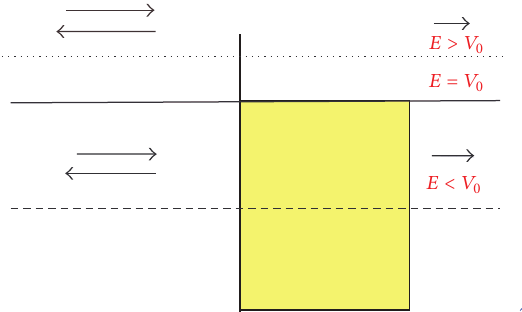
Figure 3: “Barrier” of a dielectric material with ̃𝑛 > 𝑛 .